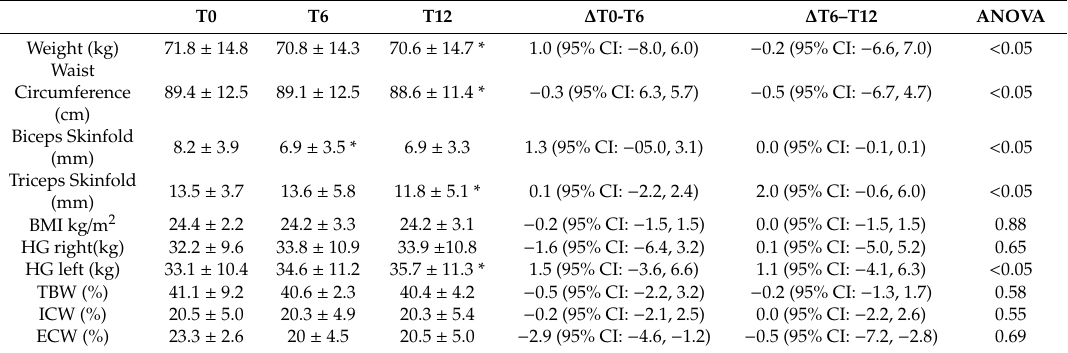
Table 1. Anthropometrics and strength parameters of all RTRs during